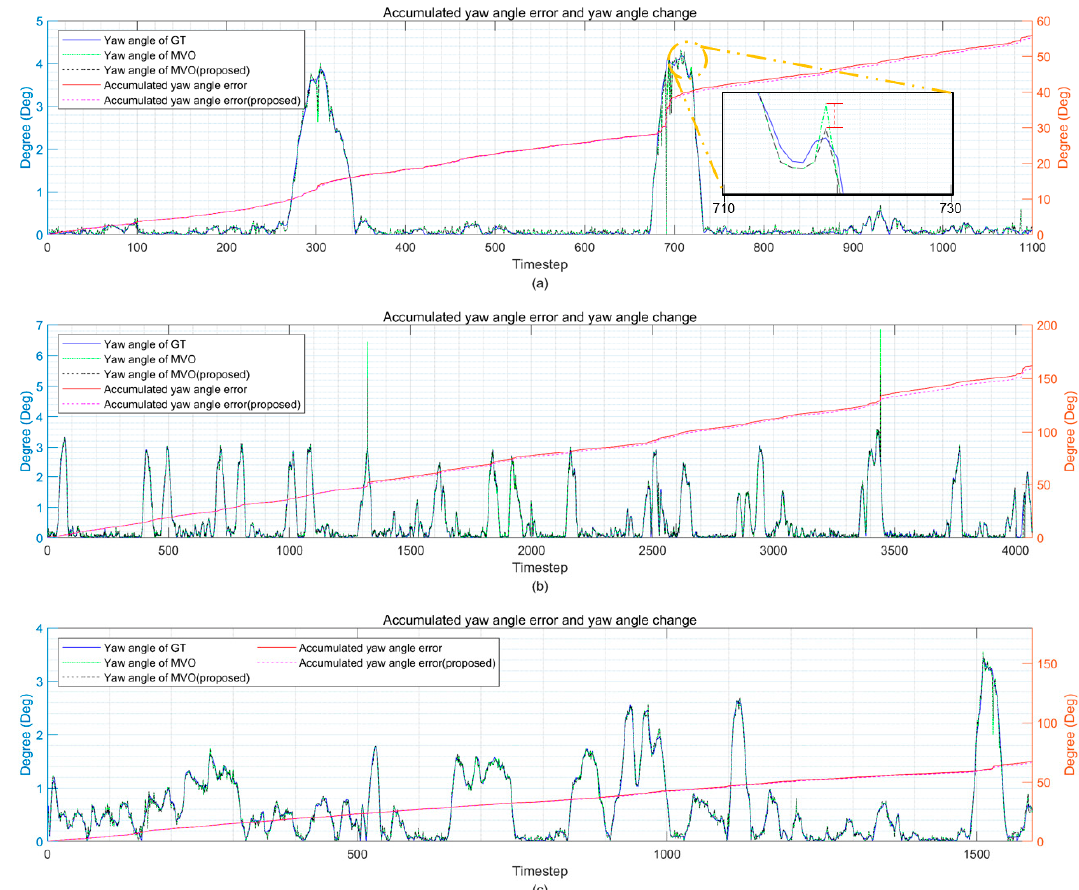
Figure 10. Accumulated yaw angle error and yaw angle of ground truth (GT) and camera calculated by the MVO and the MVO with the proposed method with KITTI 06, 08, and 09 sequences. ( a ) The KITTI sequence 06. ( b ) The KITTI sequence 08. ( c ) The KITTI sequence 09. The left vertical axis is for the yaw angle and the right vertical axis is for the accumulated yaw angle error.